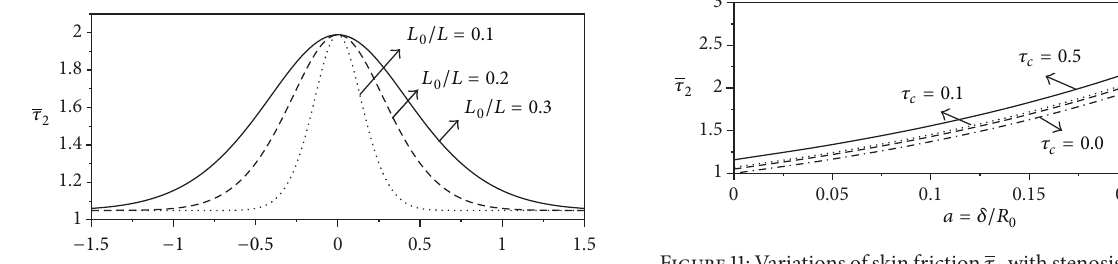
Figure 11: Variations of skin friction 𝜏 2 with stenosis height 𝛿/𝑅 0 for different values of yield stress 𝜏 𝐶